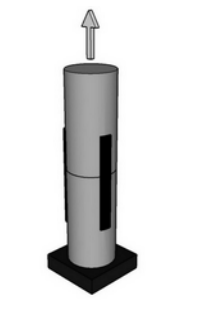
Figure 2. Aspect of direct tensile